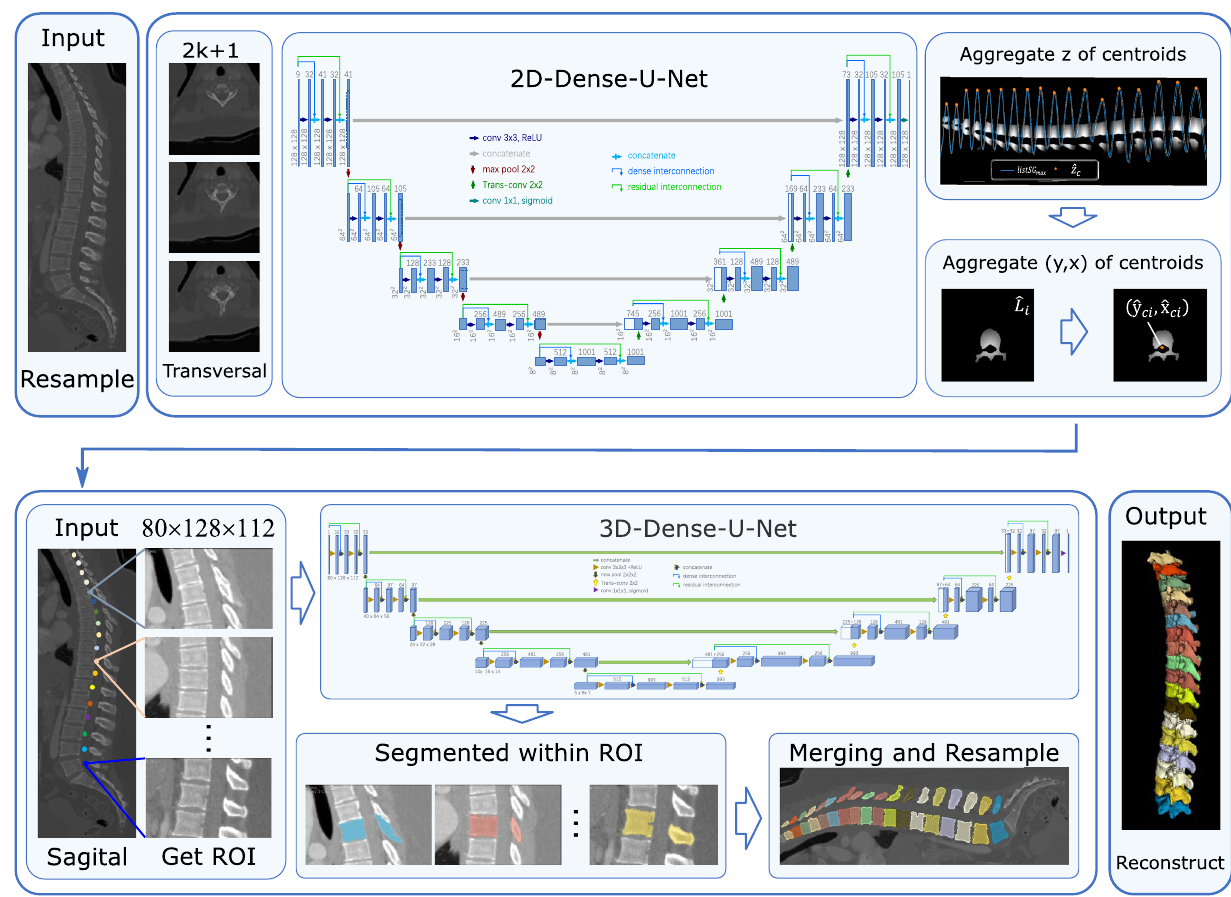
Figure 1. Overview of our proposed automatic vertebrae localization and segmentation method with a two- stage